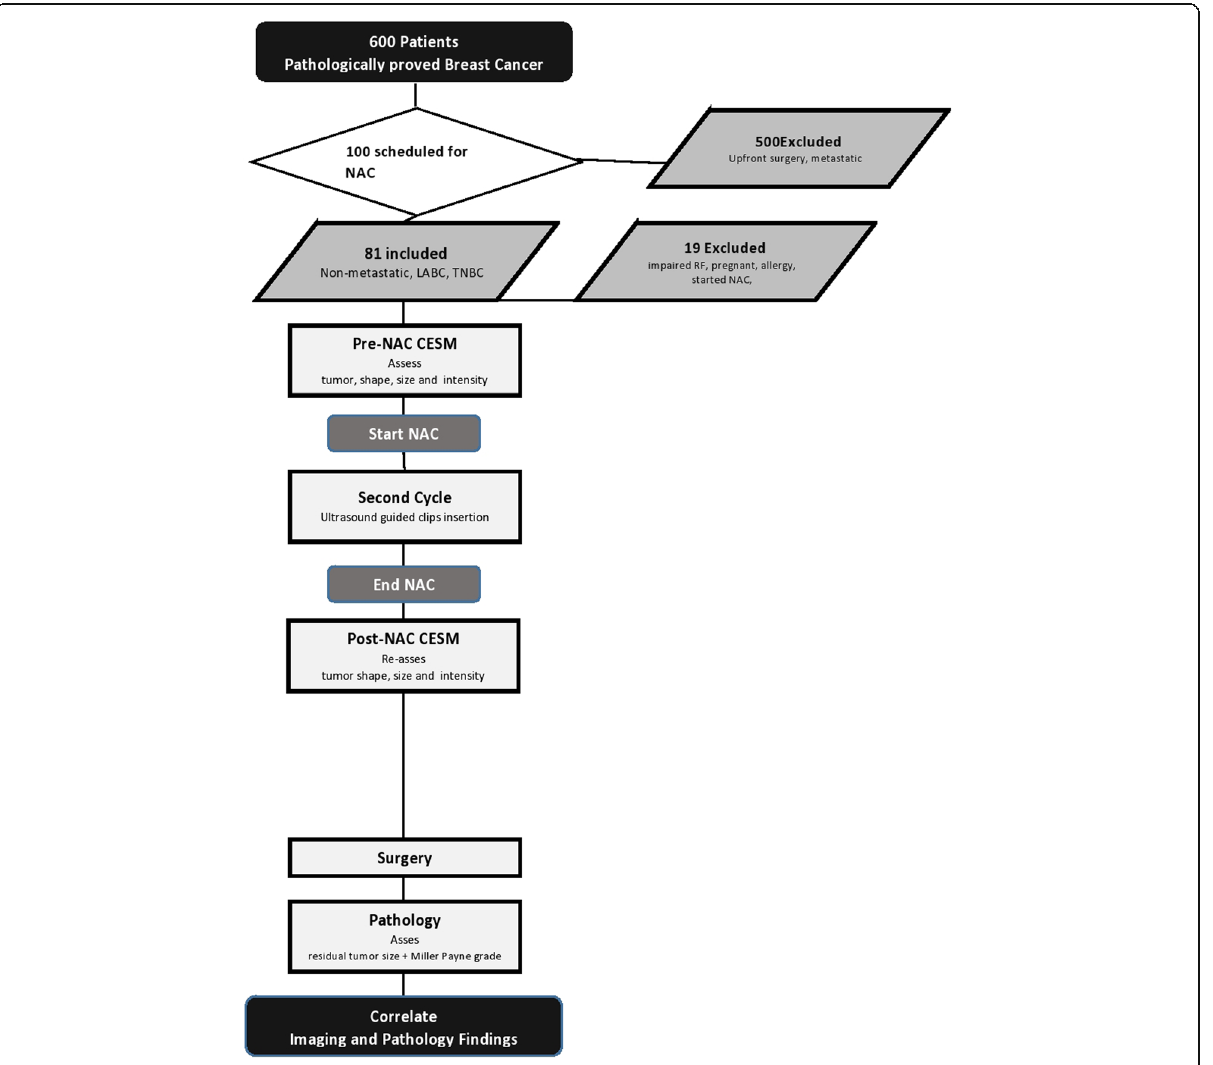
Fig. 1 Flow chart of included and excluded patients in the